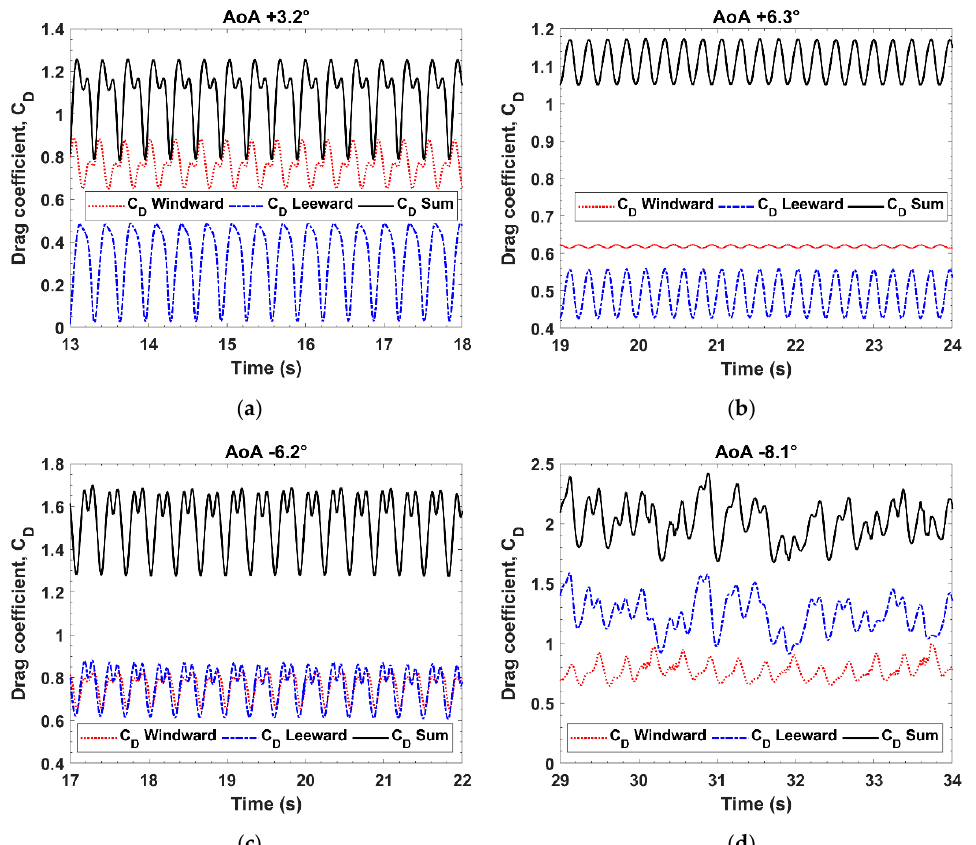
Figure 9. Time history of drag coefficient for different angles of attack: ( a ) AoA = +3.2°, ( b ) AoA = +6.3°, ( c ) AoA = − 6.2° and ( d ) AoA = − 8.1°.